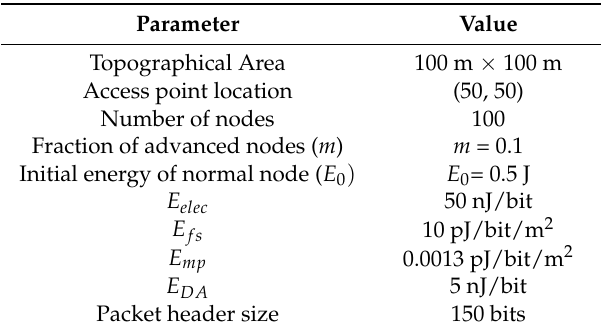
Table 2. Simulation Parameters.